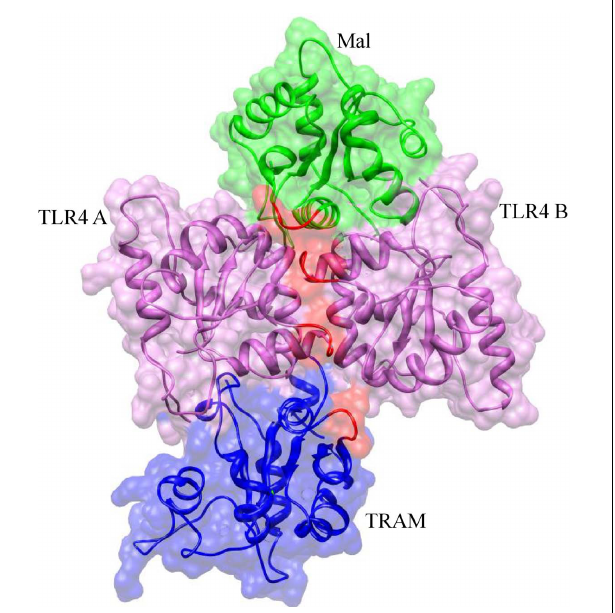
FIGURE 5 | Molecular model of MAL andTRAMTIR domains bridged to the activatedTLR4TIR domains. The BB-loops in eachTIR domain are highlighted in red. MAL andTRAM proteins are both predicted to bind to theTLR4 homodimer interface. It is probable that binding of MAL orTRAM protein is mutually exclusive, with the former binding to activated receptors at the cell surface and the latter in